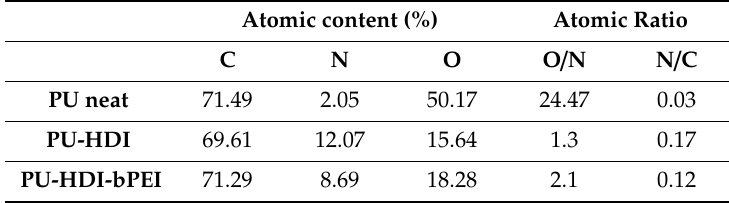
Table 2. Atomic content of PU-HDI-bPEI detected by XPS